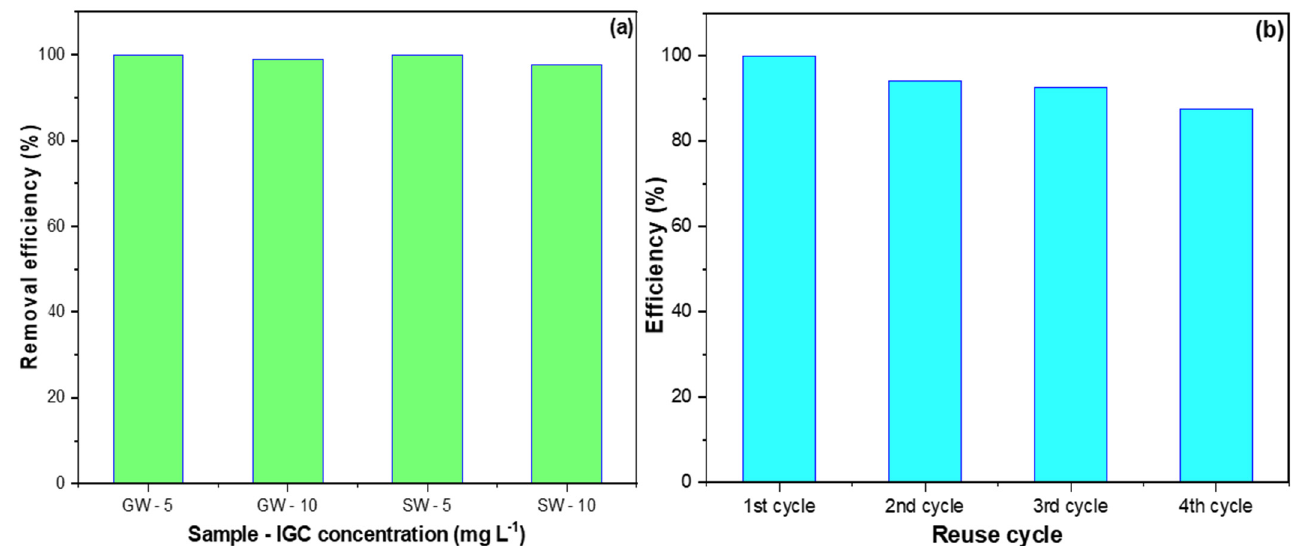
Figure 11. ( a ) Remediation of contaminated GW and SW using the Al 2 O 3 -NiO nanocomposite; ( b ) the reuse study of the Al 2 O 3 -NiO nanocomposite for removing IGC water.